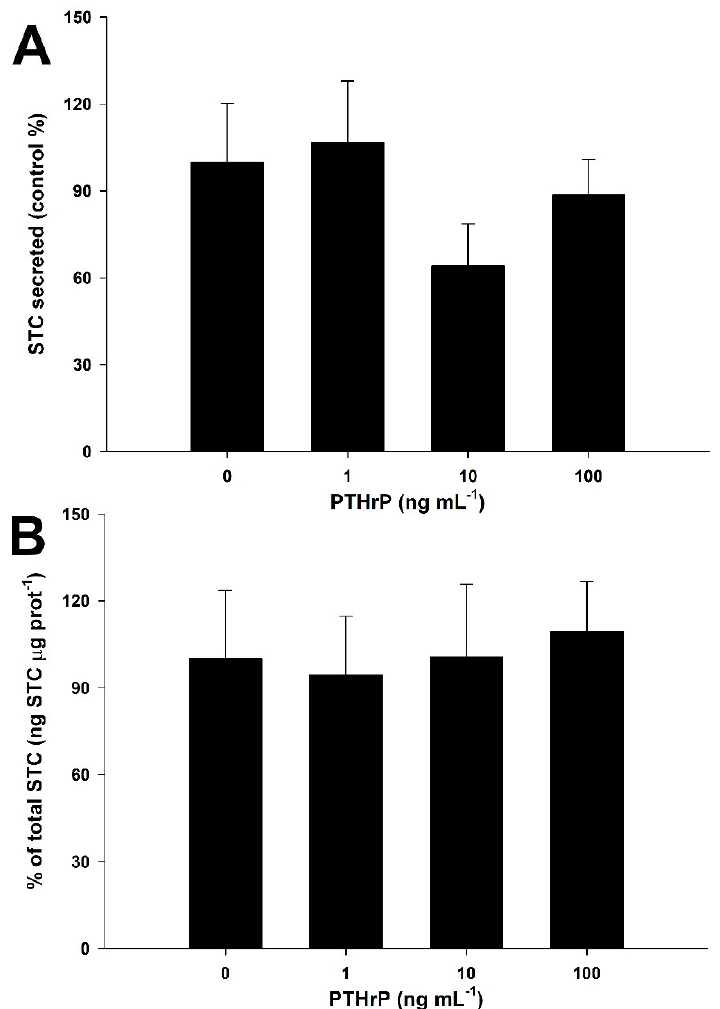
Figure 7. Dose-response effects of PTHrP on STC ex vivo secretion ( A ) and production ( B ) from the corpuscles of Stannius of the gilthead seabream at high (2.92 mM Ca 2+ ) calcium concentration. Basal STC secretion for the 0 ng PTHrP mL − 1 group is 0.82 ± 0.17 ng STC μ g prot − 1 h − 1 (mean ± SEM). No significant differences between groups were observed ( n = 9 per group, one-way ANOVA followed by a Tukey ´ s post-hoc test, p >